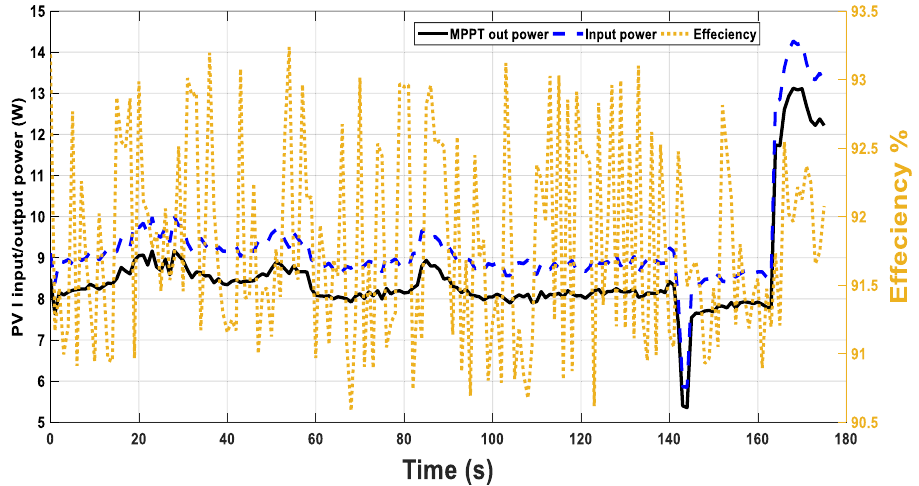
Figure 13. Adaptive MPPT with temperature and irradiance variation in one-day morning with efficiency.